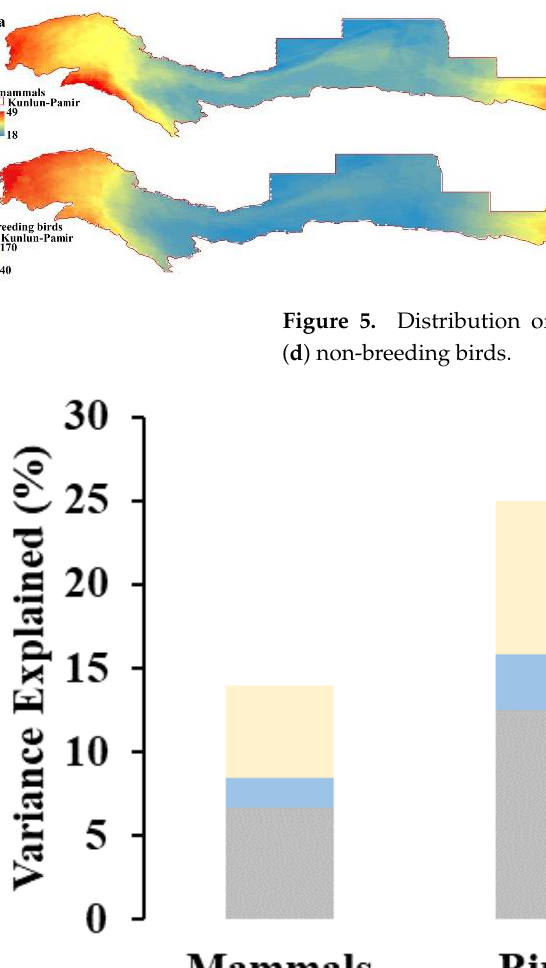
Figure 5. Distribution of species richness of ( a ) mammals, ( b ) birds, ( c ) breeding birds and ( d ) non- breeding birds.